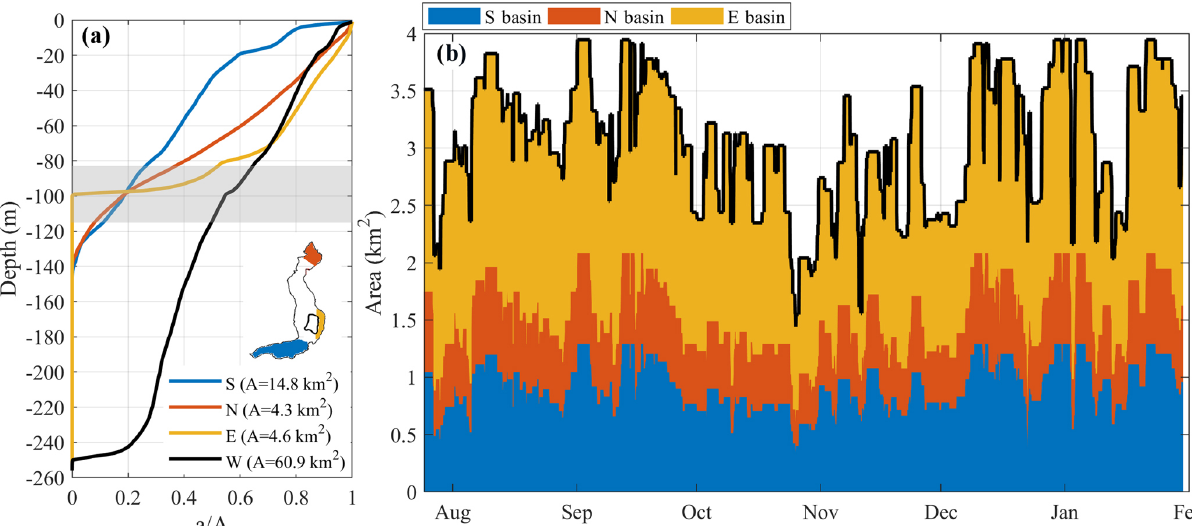
Figure 9. (b) Estimation of the area of the bottom sediments subjected to alternating redox conditions. The areas were calculated by con- sidering the oscillations of the oxycline over a 3-day-long time window. The three colors make reference to the contribution of the southern (S, blue), northern (N, red) and eastern basins (E, yellow), as shown on the map. In (a) , the area–depth curves indicate the cumulative area “a” of the bottom situated below a given water depth in the whole lake (W) and in each sub-basin (E, N, S). On the x axis, the area “a” was normalized with the total area “A” of each basin. The grey shaded area marks the maximum and minimum vertical displacement of the 0.5mgDOL − 1 recorded at LS-S, highlighting the area of the bottom where the oxycline fluctuates.